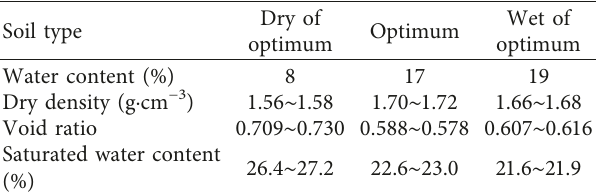
Table 3: Basic physical properties of compacted